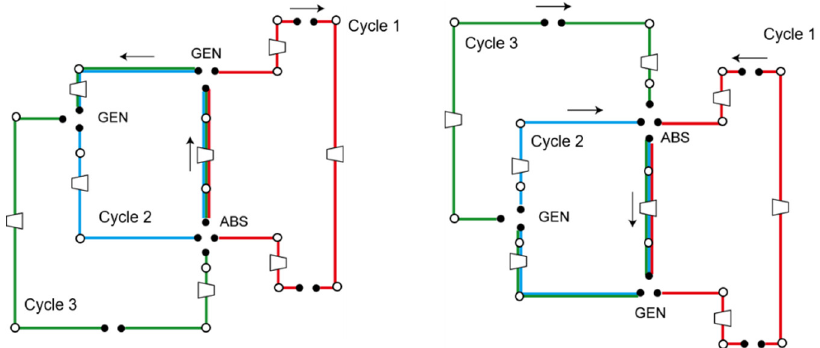
Figure 6. Examples of topologies that limit pressure range of working fluids in non-shared processes. (red line, green line—refrigerant, blue line—absorbent solution). A = { 1 1 1 } , C = { } ,A = { }, C = { 0 1 1 } , A = { } ,C = { } ( left ); A = { }, C = { 1 1 1 } , A = { 0 1 1 } , C = { } , A = { } , C = { } ( right ).